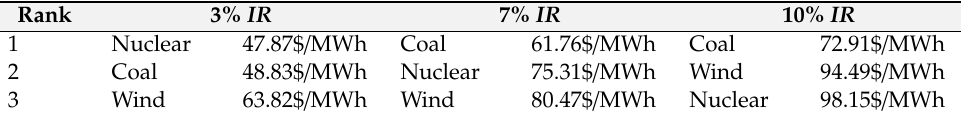
Table 4. Median LCOE values of Coal, Wind, and Nuclear at 3%, 7% and 10% IR. Rank 3% IR 7% IR 10% IR 1 Nuclear 47.87$ / MWh Coal 61.76$ / MWh Coal 72.91$ / MWh 2 Coal 48.83$ / MWh Nuclear 75.31$ / MWh Wind 94.49$ / MWh 3 Wind 63.82$ / MWh Wind 80.47$ / MWh Nuclear 98.15$ /